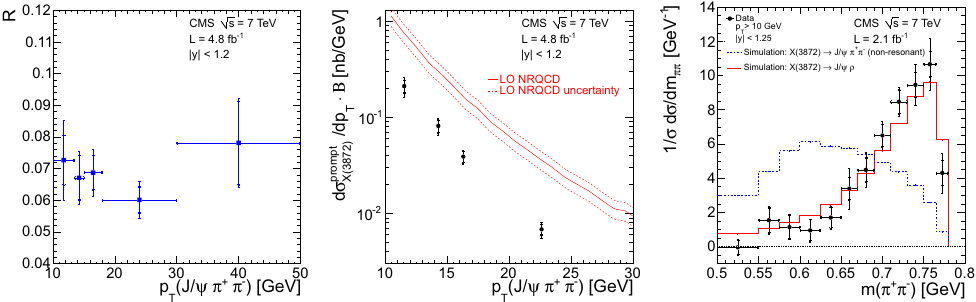
Figure 3. Ratios of the X(3872) and ψ (2S) cross sections times branching fractions with acceptance corrections for the muon and pion pairs, as a function of p T (Left). Prompt X(3872) production times branching fraction B ( X (3872) → J /ψπ + π − ) as a function of p T . The inner error bars indicate the statistical uncertainty and the outer error bars indicate the total uncertainty (Middle). The acceptance and e ffi ciency corrected dipion invariant mass spectrum for X(3872) → J /ψπ + π − (Right). The distribution is normalized dividing by the total cross section for 0.5 < m( π + π − ) < 0.78 GeV